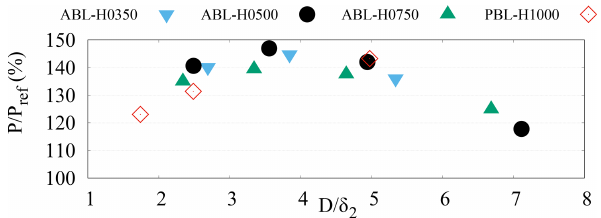
Figure 7. Power gains versus the ratio D/δ 2 of the turbine diameter to the boundary layer momentum thickness. Same data as in Fig. 6: turbines with rotor tilted by ϕ = 30 ◦ operated at C (cid:48) sidered D – H combinations with additional data from C2020 (PBL) also reported for